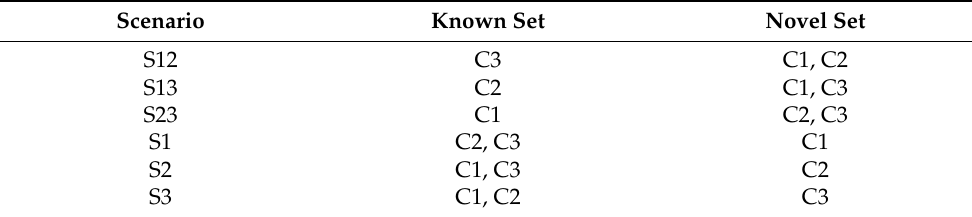
Table 2. Scenarios used for the evaluation of the novelty detection task with no anomaly.